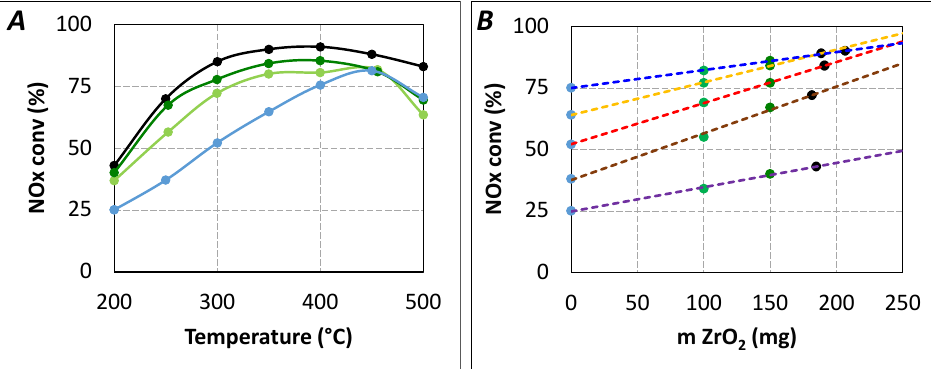
Figure 8. Influence of ZrO 2 weight in DeNO x efficiency for urea residence time of 4.0 s in standard condition (400 ppm NO, 400 ppm eq. NH 3 , 8% H 2 O, 10% CO 2 , 10% O 2 ). ( A ) NO x conversion versus temperature. (▬): SCR catalyst ( t R = 5.2 s); (▬): ZrO 2(100mg) + SCR catalyst ( t R = 4.0 s); (▬): ZrO 2(150mg) + SCR catalyst ( t R = 4.0 s); (▬): SCR catalyst ( t R = 4.0